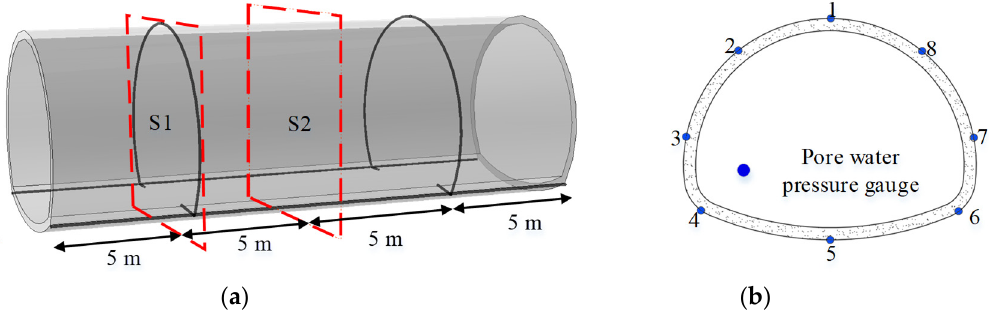
Figure 6. Measurement configuration diagram: ( a ) monitoring sections; ( b ) monitoring point.